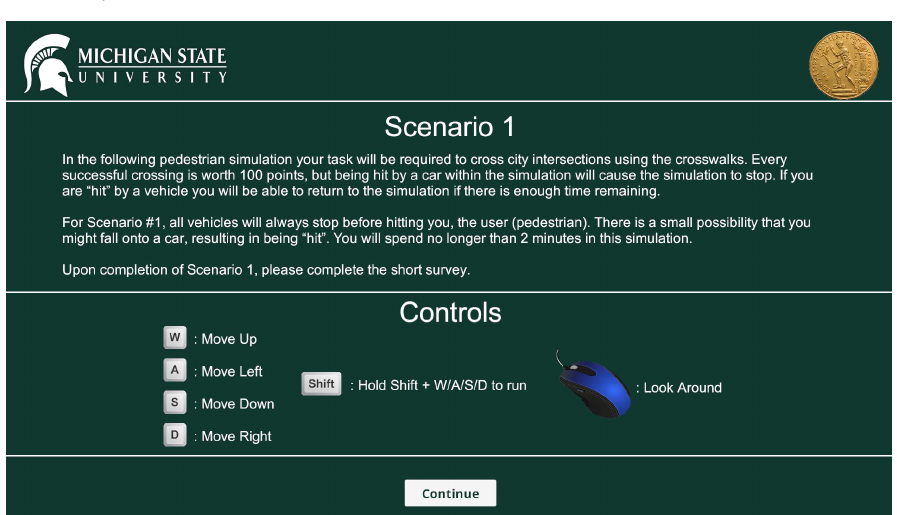
Figure 10. The guidelines explain the concept of each scenario before loading